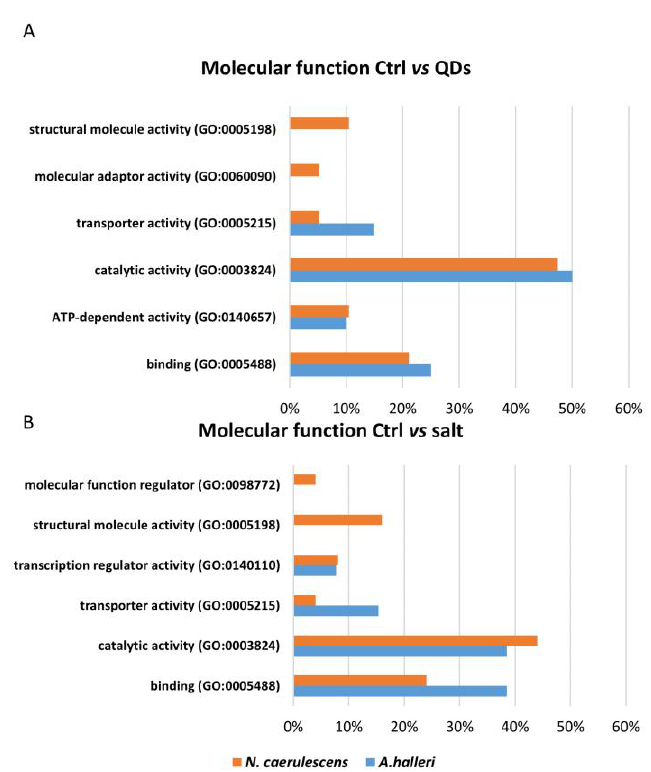
Figure 4. The GO analysis of molecular function. The genes list inserted are genes that code for proteins identified using comparative pairwise proteomic analysis between control, treated with metal QDs and metal salt. Blue bars represent the percentage of the proteins found in A. halleri , while orange bars represent the percentage of the proteins found in N. caerulescens .